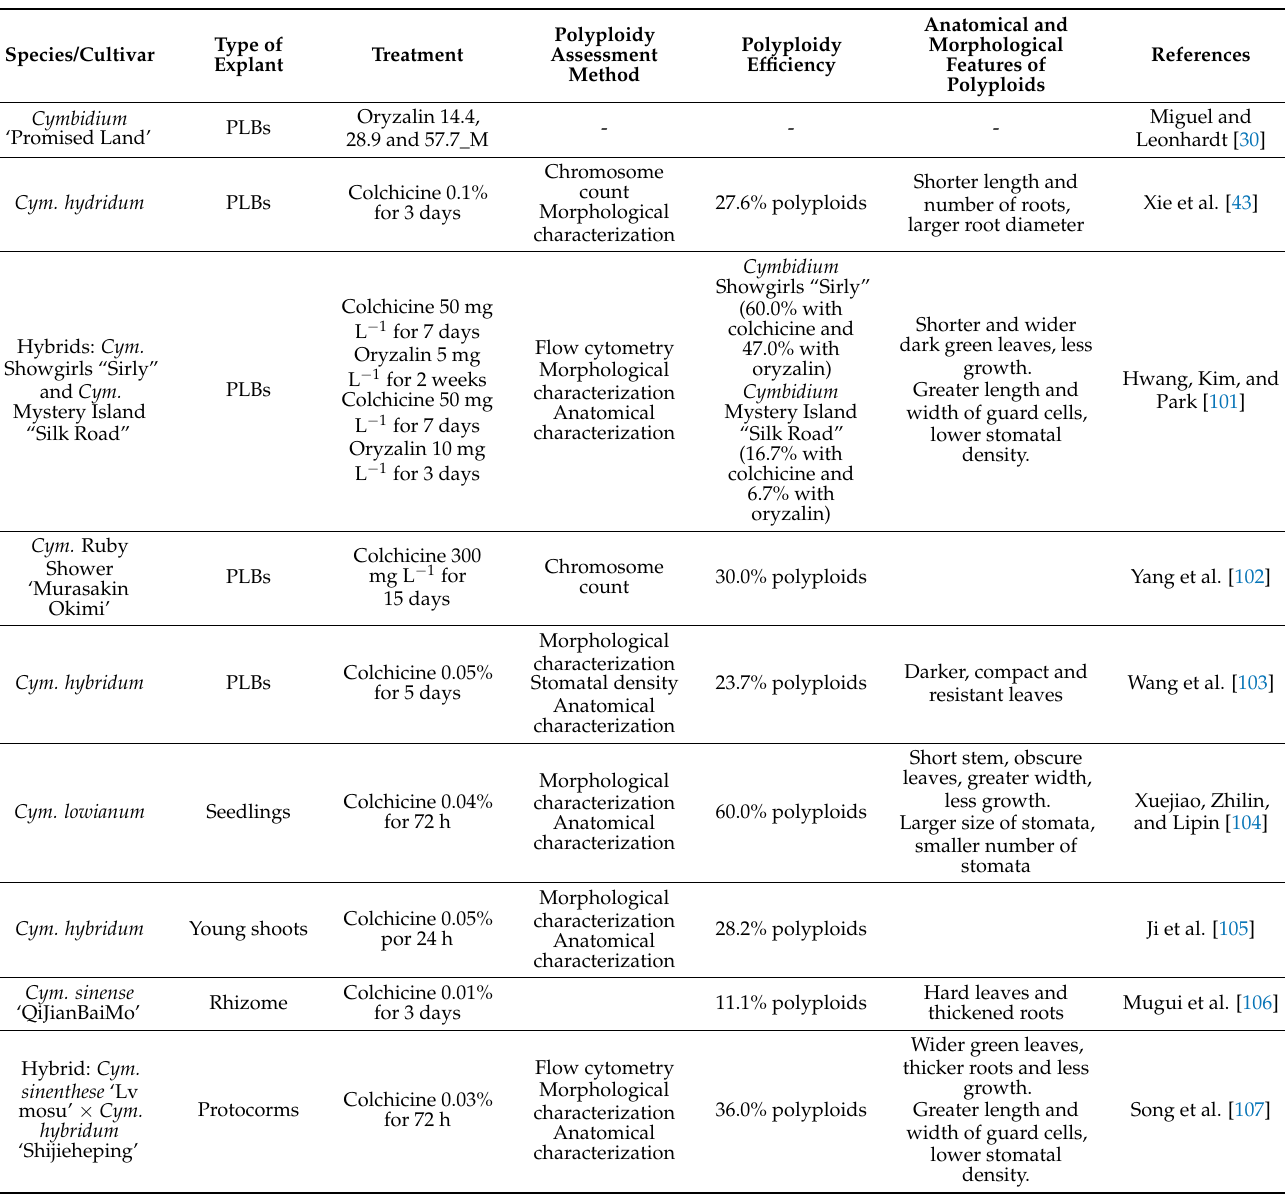
Table 3. Polyploidy induction of Cymbidium using antimitotic